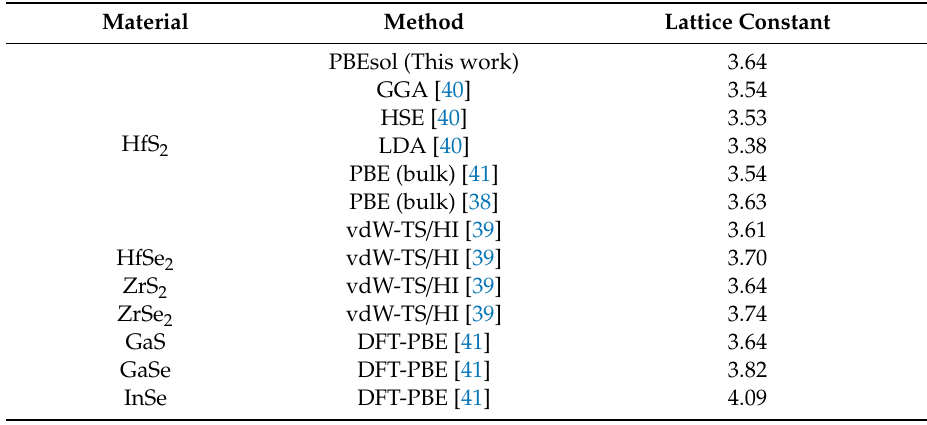
Table 1. Comparison of the lattice constants of 2D HfS 2 are calculated using different exchange- correlation functions along with the other reported values in the literature.